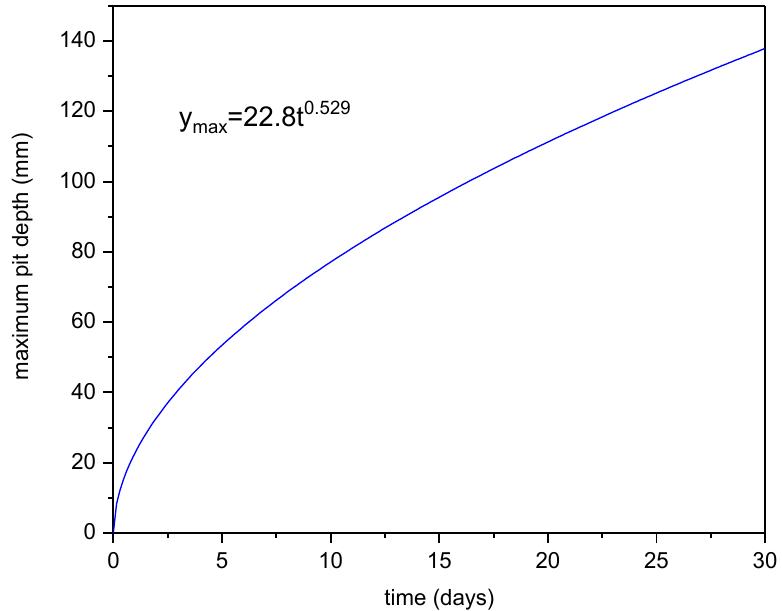
Figure 6. Maximum pit growth evolution as a function of immersion time of pipeline steel in synthetic-produced water according to the results obtained by Velázquez et al. reprinted with permission from ref. [46]. Copyright 2022 Elsevier.